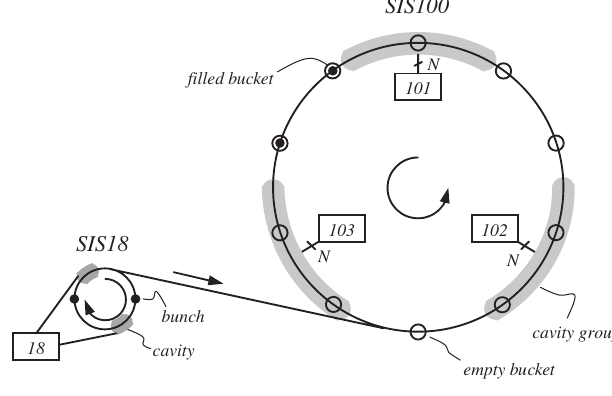
FIG. 2. Bunch-to-bucket transfer.